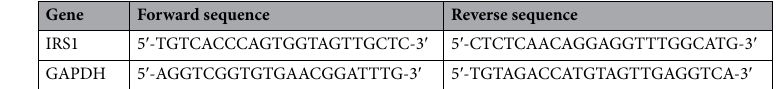
Gene Forward sequence Reverse sequence Table 1. The primers sequences used were as follows: